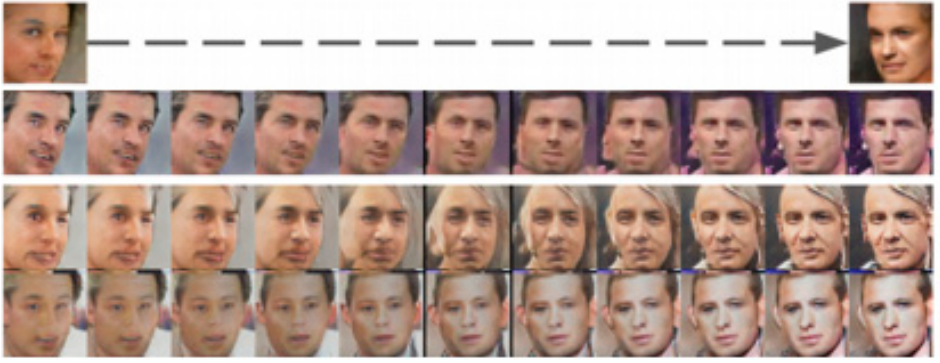
Figure 42. Face generation in different angle using GAN.